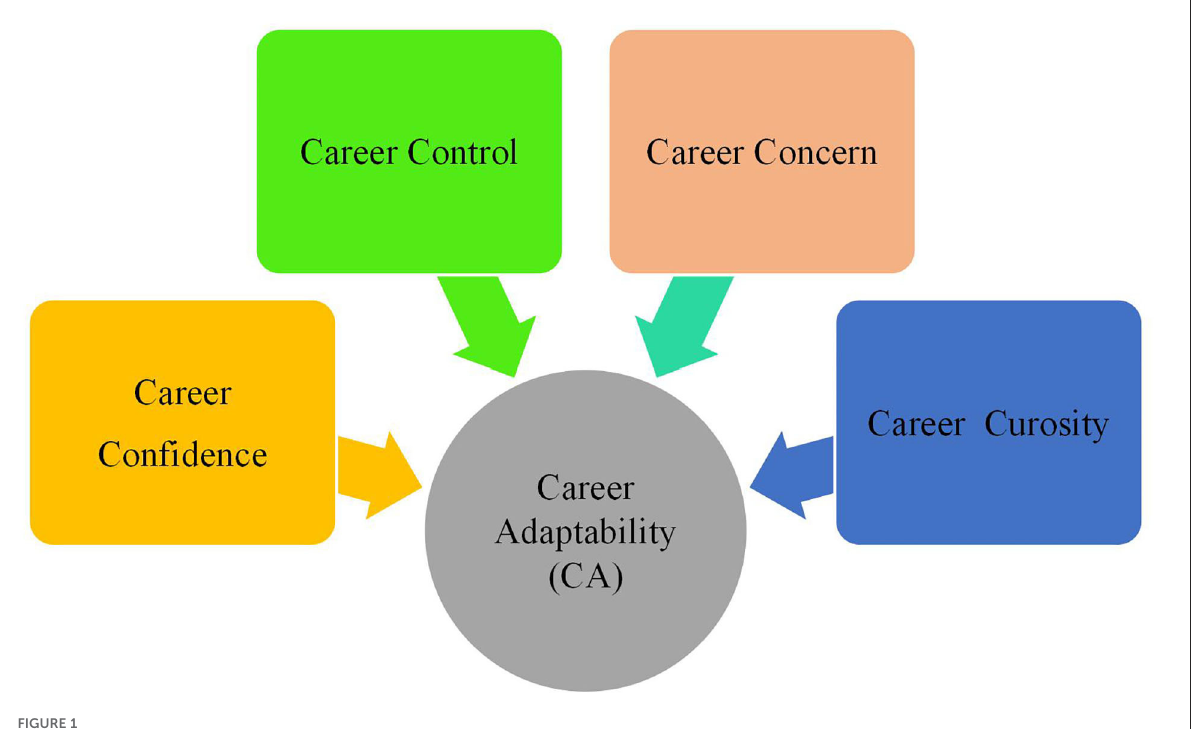
FIGURE1 The dimensions of career adaptability (Savickas, 2005, p.